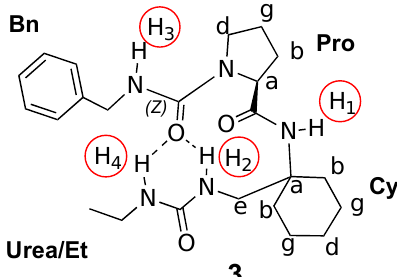
Figure 3. Structure of peptidomimetic 3 , detailing the nomenclature system used for its structural study. (For the units: Urea/Ethyl, Cy, Pro and Bn. For the positions in each unit: Greek alphabet. For NH: H 1 , H 2 , H 3 and H 4 ). The study was started by acquiring NMR experiments ( 1 H, 13 C and TOCSY) leading to the assignment of the signals of the compound (Figure 4 and Table 1).